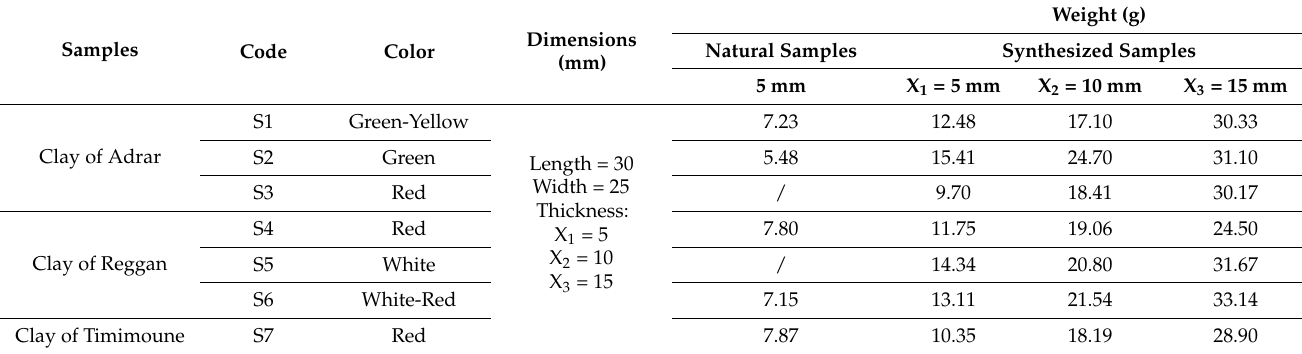
Table 1. Characteristics and specifications of the studied